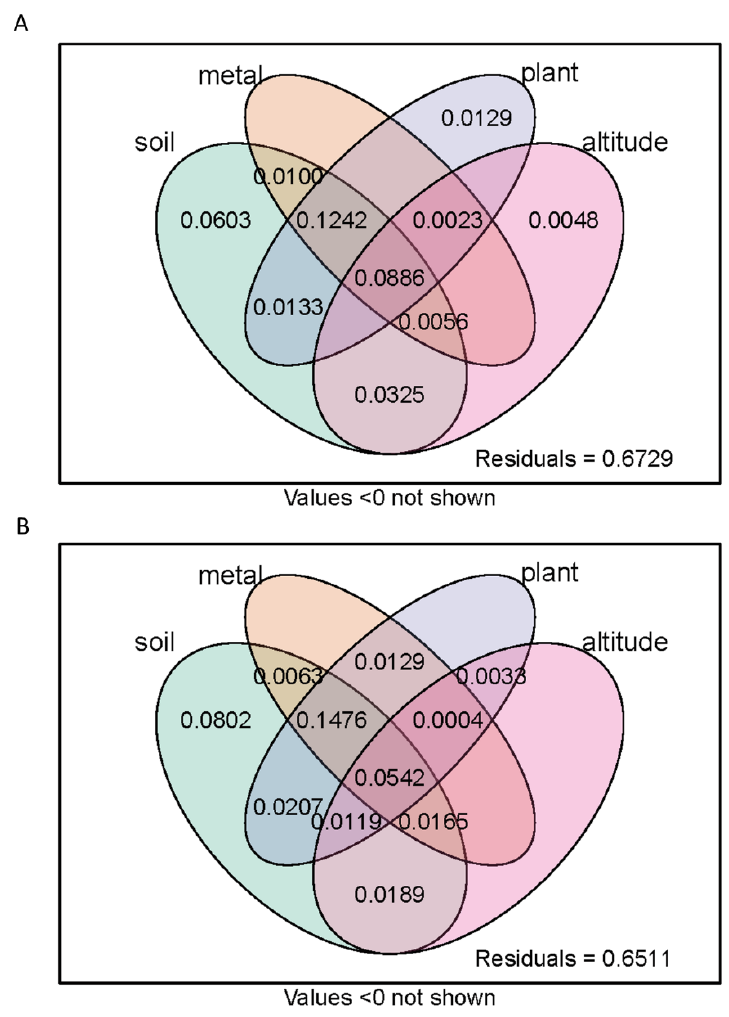
Figure 13. Variation partitioning analysis (VPA) which showed the relative proportions of total ( A ) bacterial and ( B ) functional diversity composition variations that can be explained by different types of environmental factors. The circles show the variation explained by each group of environmental factors alone.